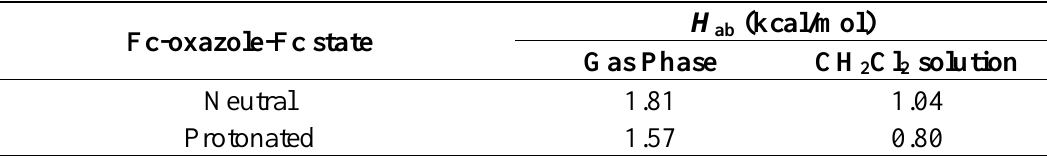
Table 5. Calculated electronic coupling for Fc-oxazole-Fc